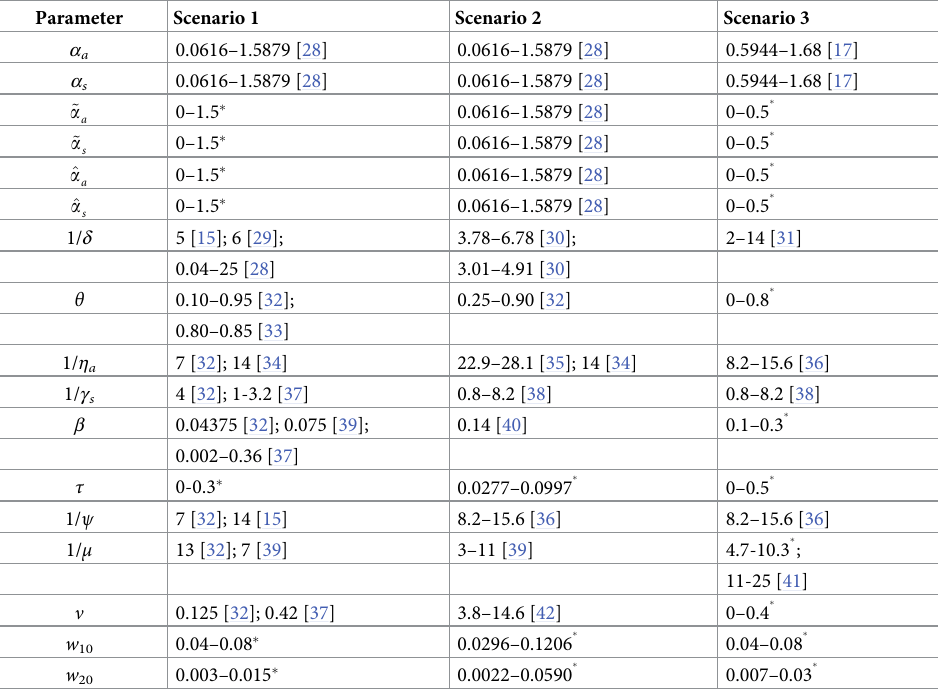
Table 3. Initial parameter ranges and values, taken from current literature or assumed ( � ) by the